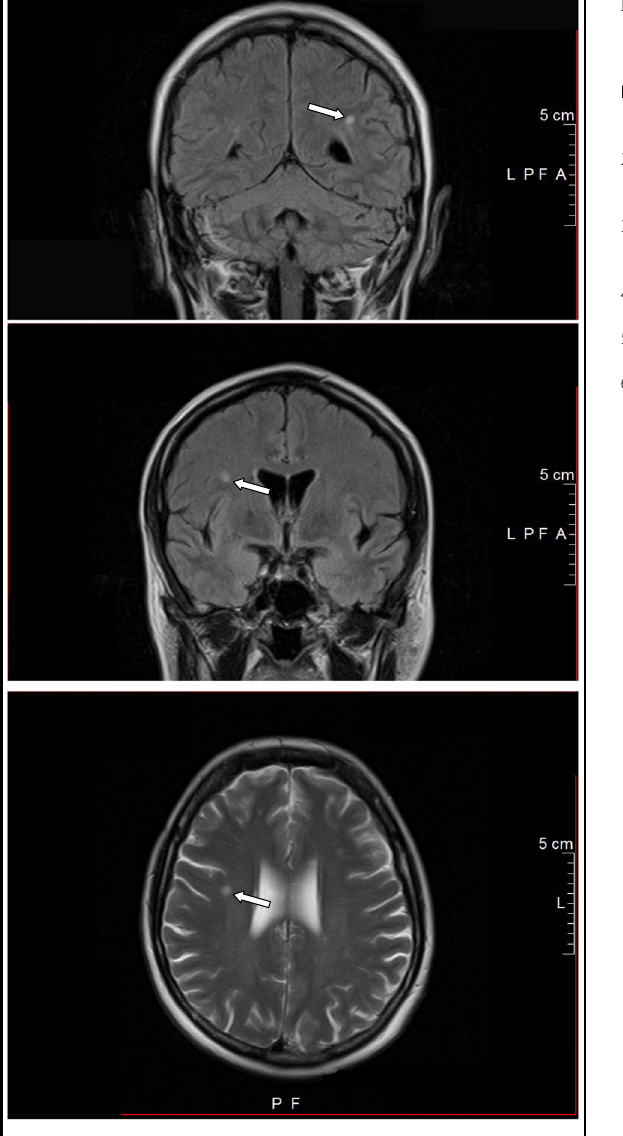
Fig. 1 Selected punctate white matter abnormalities (see arrows) in a 55-year-old female patient with systemic mast cell activation syndrome with neurological symptoms ( “ fi bromyalgia phenotype ” 2 ). The number of WMAs (one WMA fi rst detected in the year 2005) has increased in the course of the disease. The magnetic resonance tomography pictures shown were made in the year